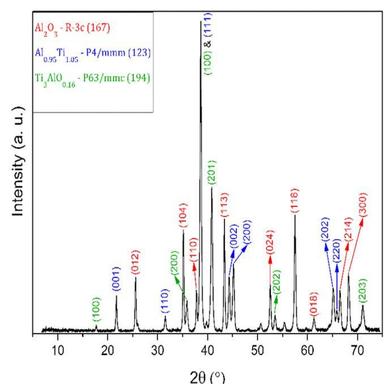
XRD spectrum of the cermet showing three distinct phases presented in the material. The legend shows the phases associated with each color, along with their corresponding space groups.